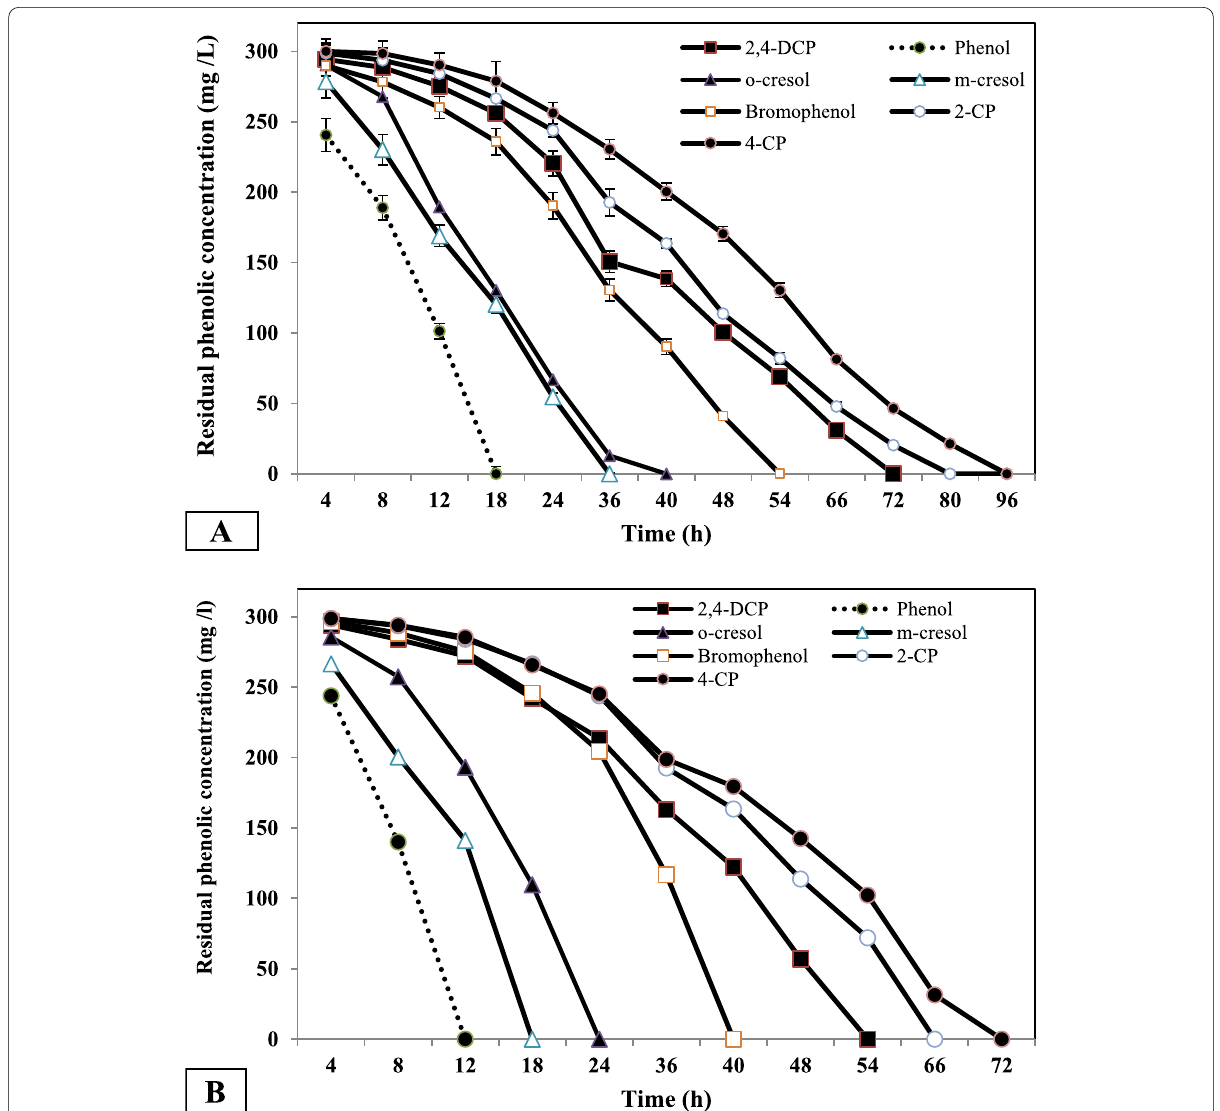
Fig. 3 Biotransformation of different PCs by free ( A ) and immobilized cultures ( B ) at different time interval. Data are represented as mean across technical replicates ( n =